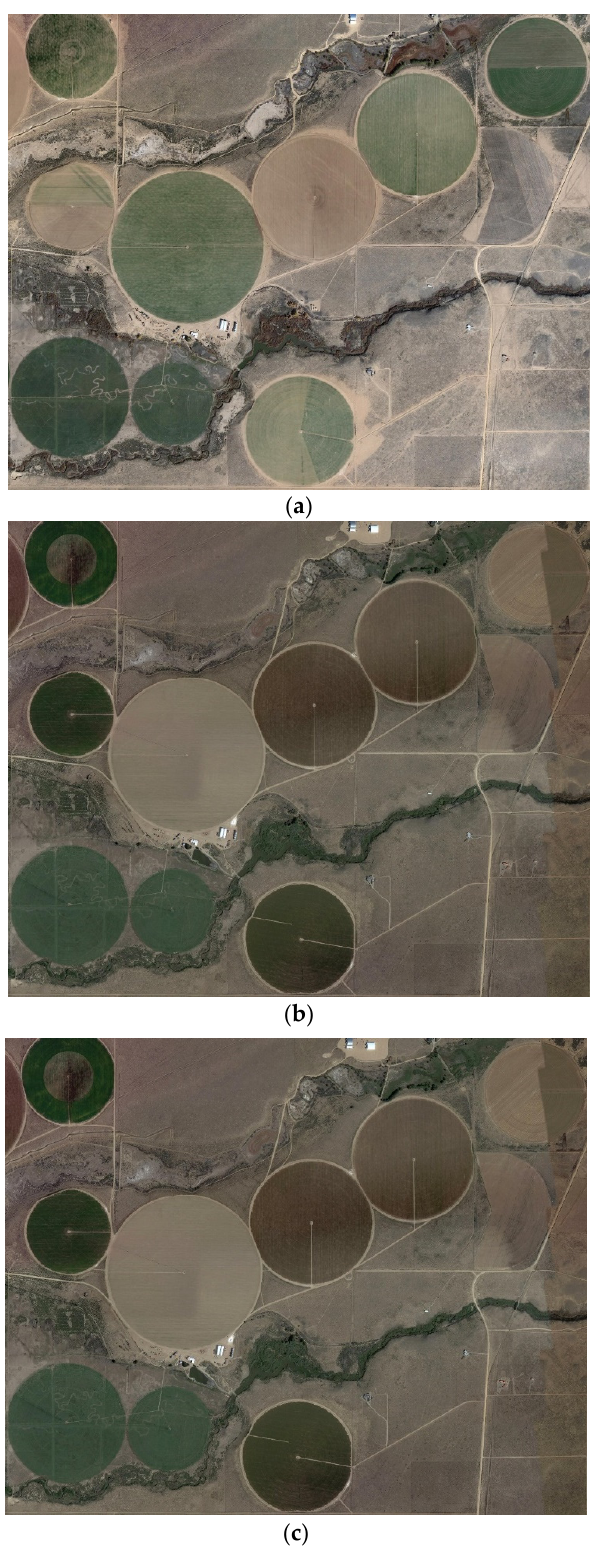
Figure 8. Three georeferenced satellite images (obtained using Google maps) obtained over three different dates ( a ) 23-10-2011 ( b ) 09-09-2016 ( c ) 30-12-2018 (used for state 4). If we demonstrate the extracted circles from images (a), (b) and (c) of Figure 8 by red, green and blue color respectively, the resulting circles are as in Figure 9. It can be ob- served, some of the resulting circles are non-overlapping while in some areas, as in the worst case, all 3 circles are in contact and are specified by red, green, and blue colors. In some area, two colors from RGB overlap and combined and cyan, yellow, and pink colors result. Finally, in rare cases, by complete overlapping of the circles, white color results. For this case, the resulting radius by conventional FCSS is reported in Table 12. We can observe various values for each circle are obtained by conventional FCSS (in an un-regular manner, it means the resulting radius from the first image in some cases is the min value, in other cases is the max value, etc.). This ambiguity will be increased, by increasing the number of available images. Furthermore, computational complexity will be increased by growing the number of available images as well. For this reason, FCSS must be applied on image circles separately. Figure 9. The extracted circles from images (a), (b) and (c) Figure 8 represented by red, green and blue colors, respectively.